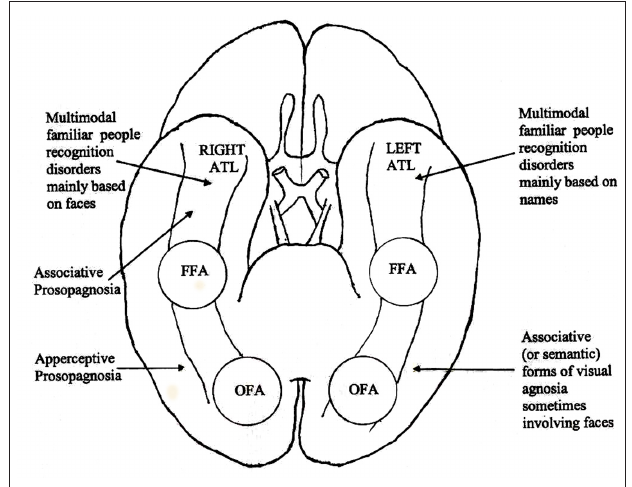
Figure 1 | Critical areas of the right and left, temporal and occipital lobes that could play a critical role in different varieties of prosopagnosia and of multimodal people recognition